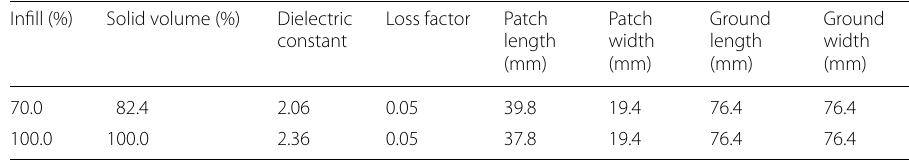
Table 2 Dimensions of the antenna samples